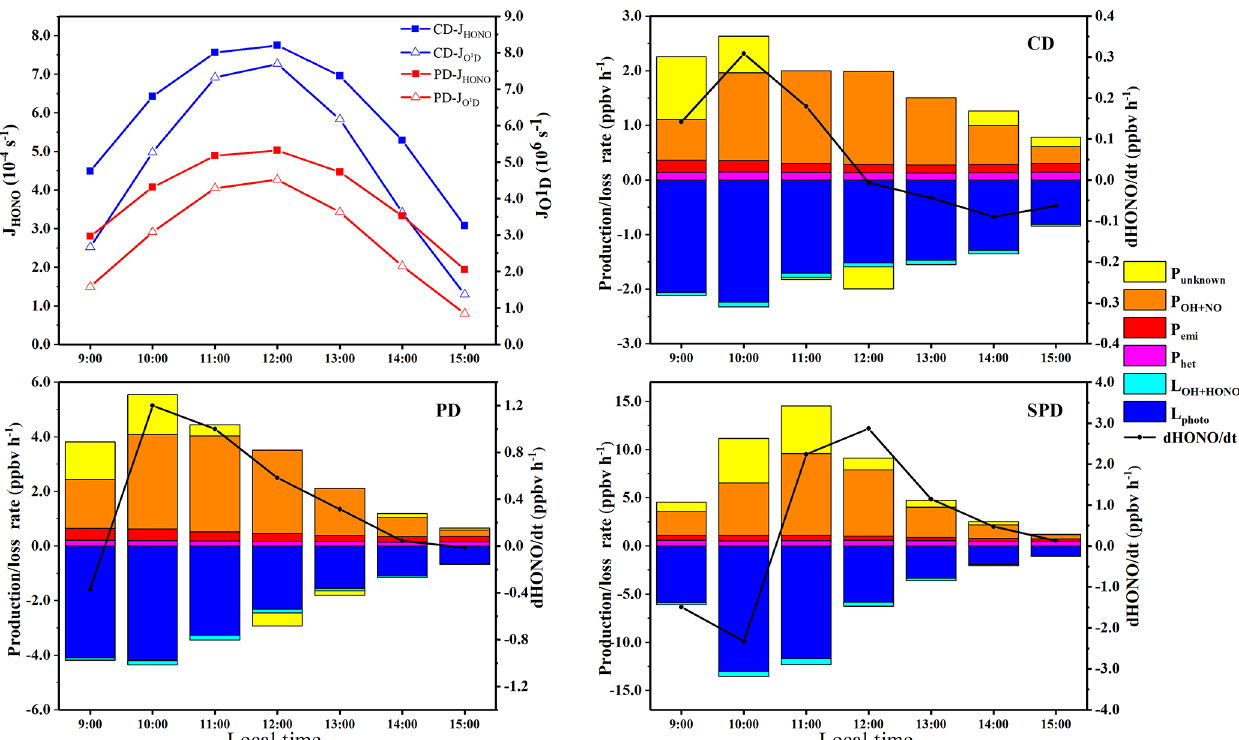
Figure 9. The average profiles of J HONO and J HONO in CD, PD, and SPD